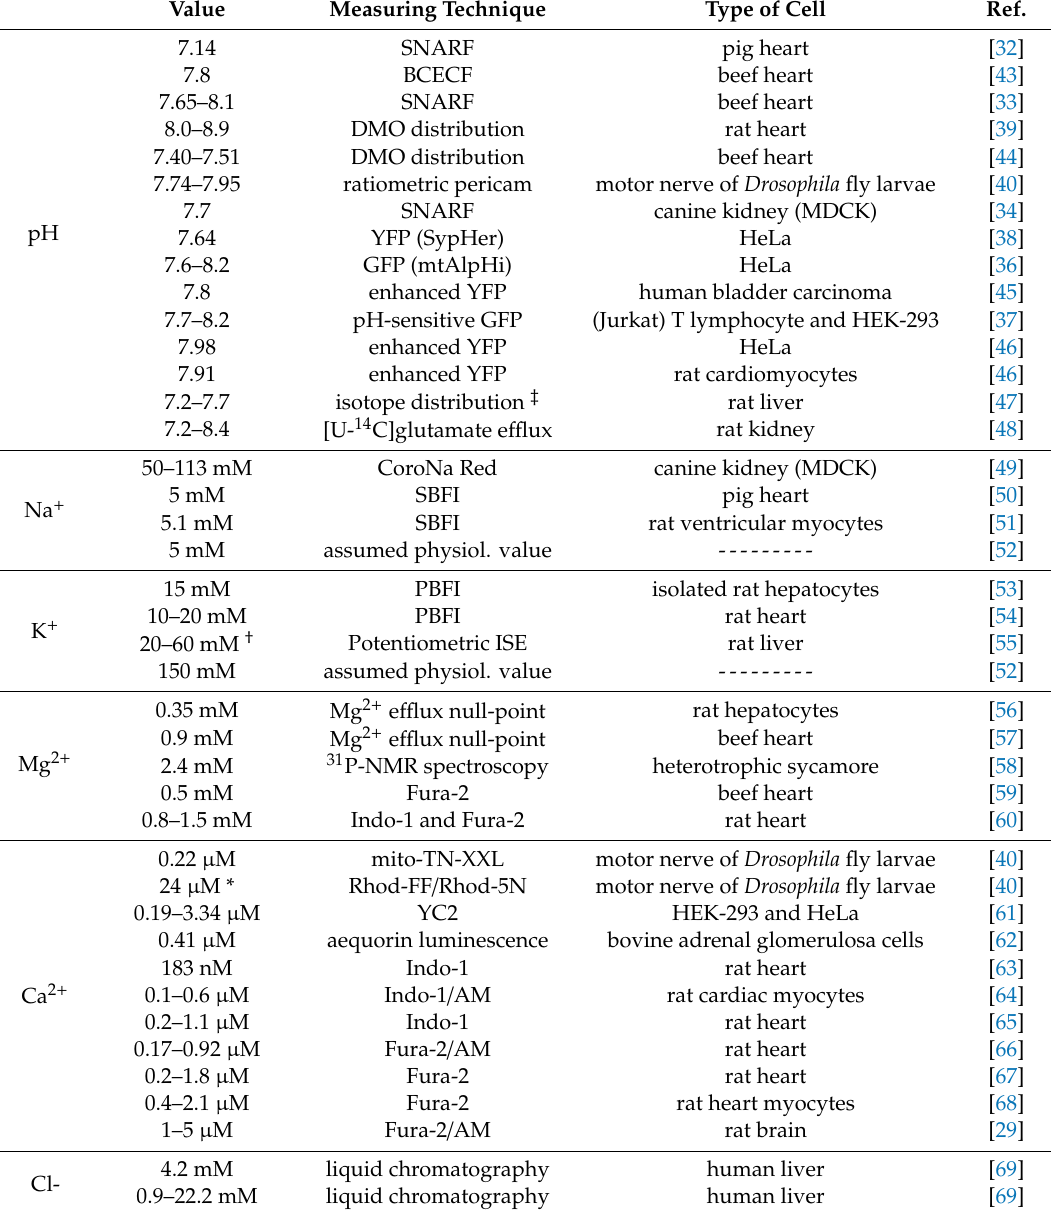
Table 1. Mitochondrial concentrations of selected inorganic